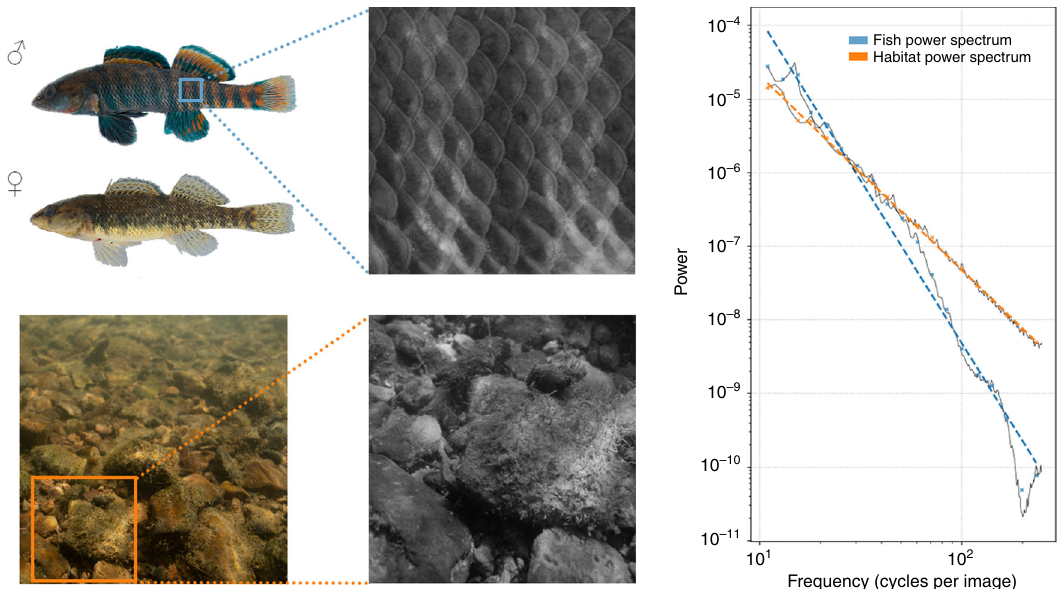
Fig. 2 Examples of fi sh and habitat images. Left column (top to bottom): male and female E. caeruleum , as well as an example image of a gravel habitat. Middle column (top to bottom): cropped sections of the original images used for computing the Fourier slope. Third column: Fourier power spectrum for a male E. caeruleum (blue) and a gravel habitat image (orange).